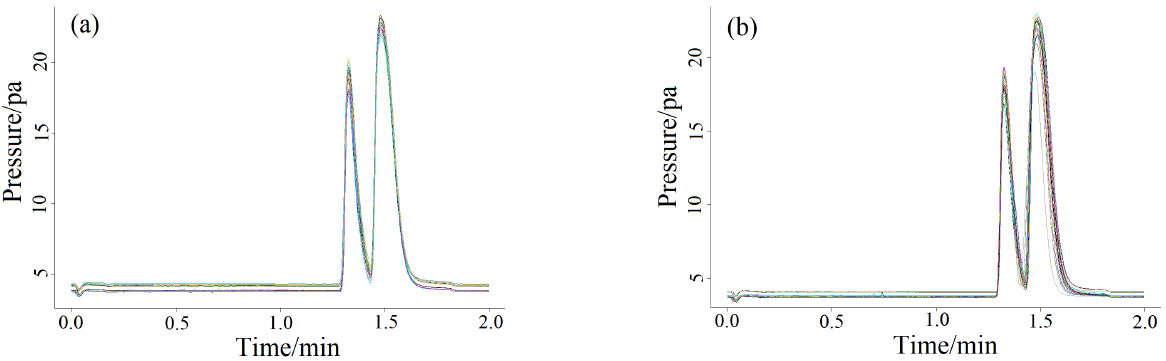
Figure 2. Ghost peaks of methane at different FID-detector ( a ) and gasification chamber ( b ) tempera- ture (10 ◦ C/interval, 5 repetitions per sample) based on manual splitless